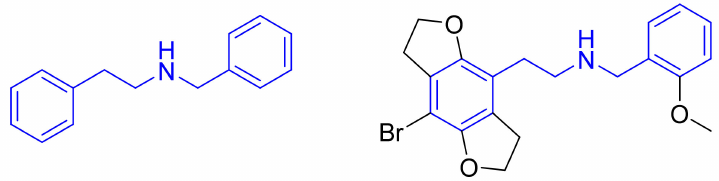
Scheme 1. The chemical structure of NBPEAs and 2C-B-Fly-NBOMe ( 1 ). 2-(8-Bromo-2,3,6,7-tetrahydrobenzo[1,2-b:4,5-b’]difuran-4-yl)- N -(2-methoxybenzyl)ethan- 1-amine (2C-B-Fly-NBOMe, compound 1 ; Scheme 1), a substance belonging to the